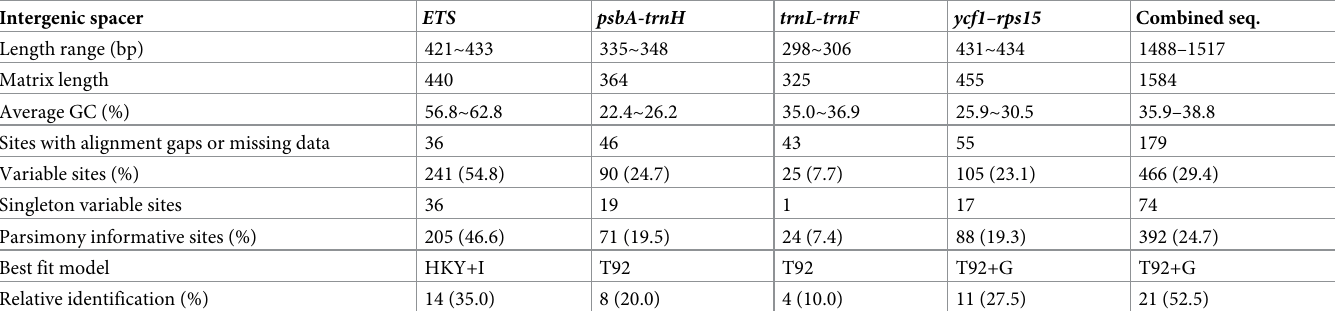
Table 3. General features of the intergenic spacers of the cultivated S . miltiorrhiza populations. Intergenic